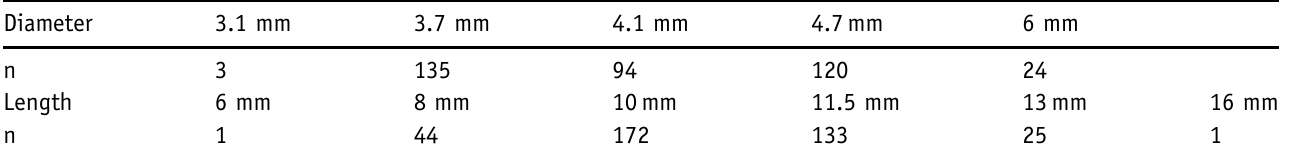
Table IV. Diameter and length of placed implants.